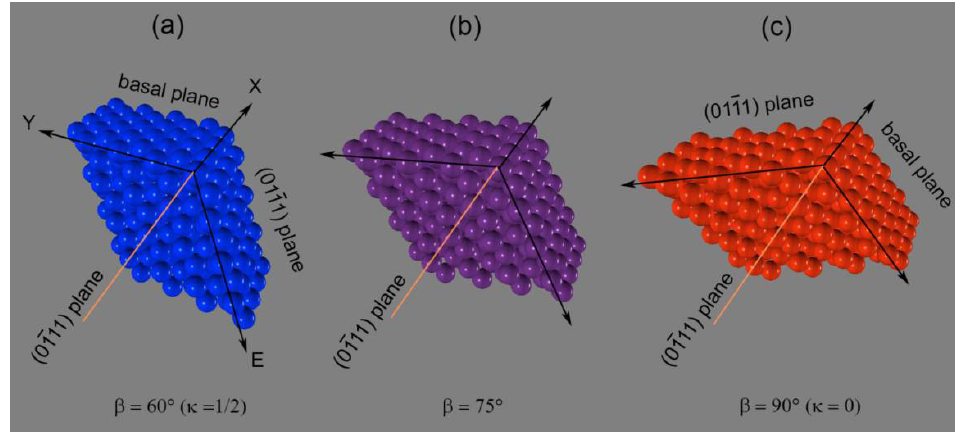
Figure 32. Snapshots of three states during the formation of a (56°, a ) contraction twin on the (0111) plane in magnesium, simulated with the displacive hard-sphere model. ( a ) Initial hcp crystal; ( b ) intermediate state at midway; ( c ) newly formed hcp crystal. This figure is made to help understand the crystallographic exchange between the basal plane and the (0111) plane. Reprinted from [147] with permission from the International Union of Crystallography.